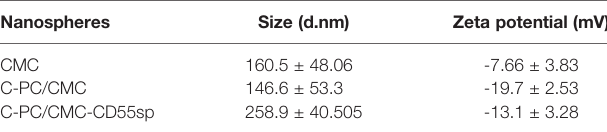
TABLE 1 | The sizes and zeta potentials of the developed